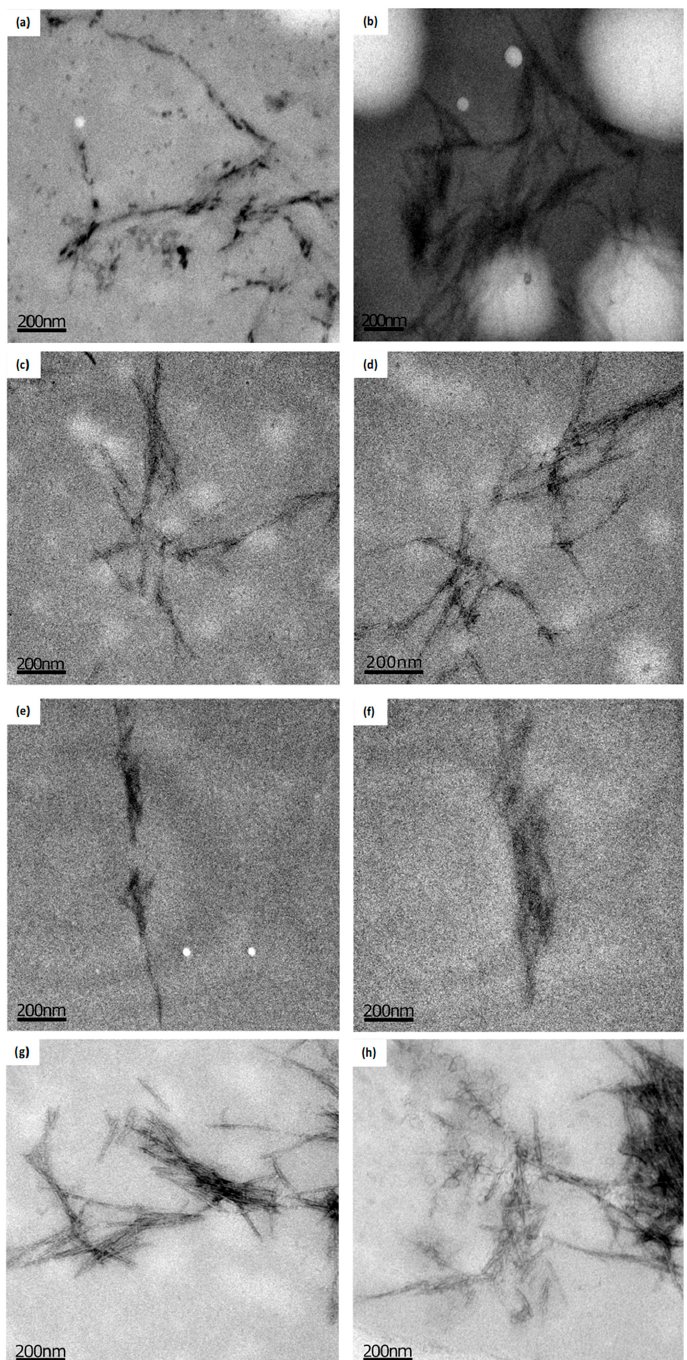
Figure 3. Cellulose nanocrystals obtained by Transmission Electron Microscopy (TEM) (PTA contrast and uranyl). ( a ) and ( b ) Corn husks; ( c ) and ( d ) Corncob; ( e ) and ( f ) Wheat bran; ( g ) and ( h ) Coconut shell (Scale: 200 nm).